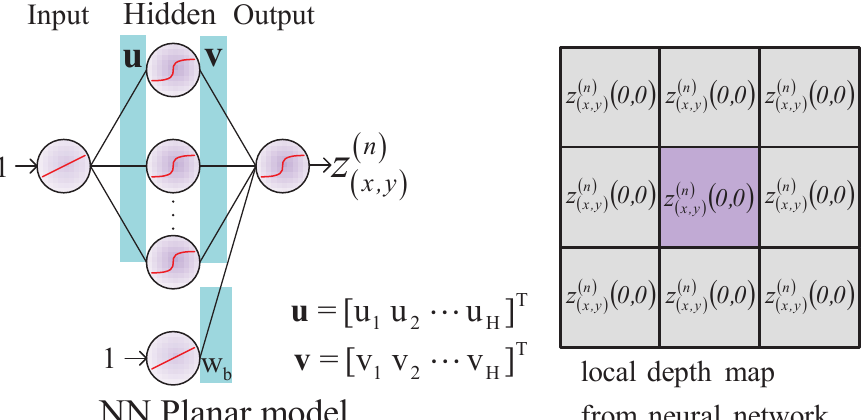
Figure 3. Proposed neural network structure for shape recovery of neural network model over Planar and local depth map from the neural network model. Left : NN.Planar model; Right : local depth map from NN. Planar model. The local depth map consists of 9 neighboring pixels centered around ( x , y ) , when small window size is 3 × 3. In addition, all local depths are same to the depth at center, so it can reduce the dimension of input layer from 3 to